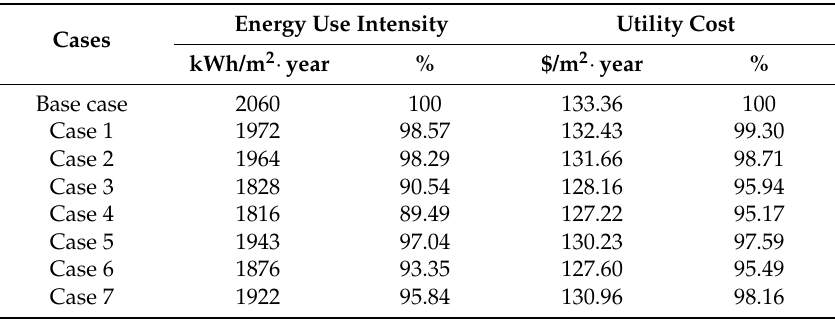
Table 9. Energy use intensity and normalized utility cost